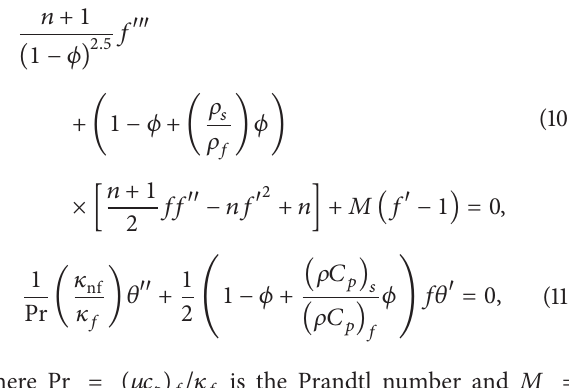
Figure 2: 𝑏 = 0.5 , 𝑓 𝑤 = 0.5 , Pr = 6.2 , 𝑀 = 0.5 , and 𝐴 = 0.5 .